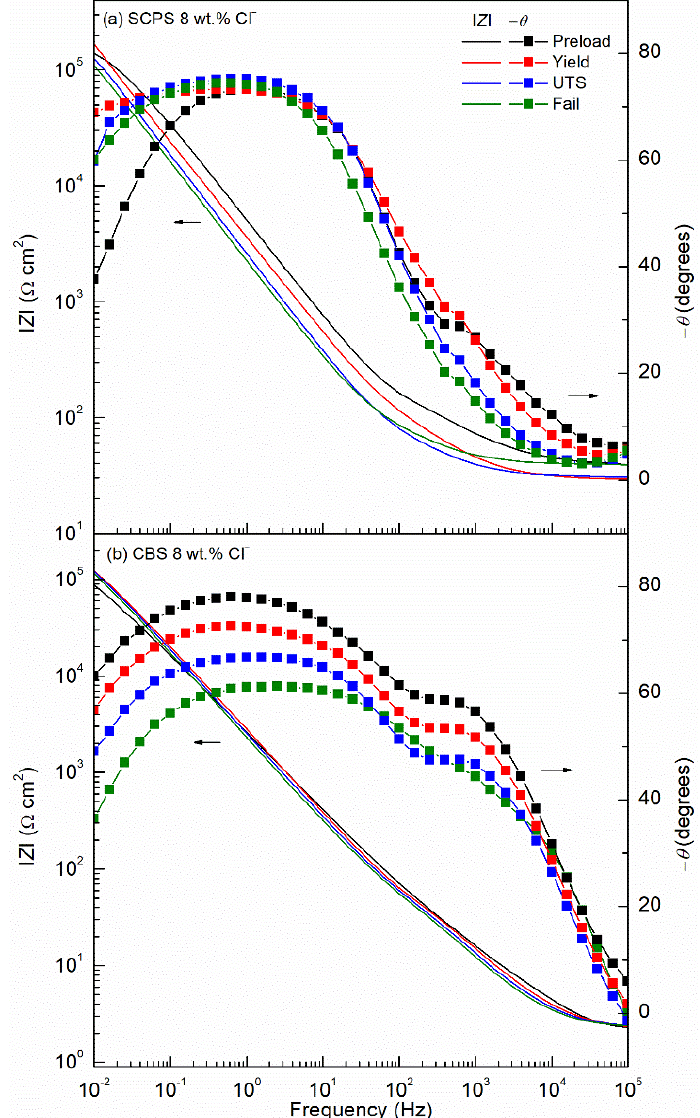
Figure 9. Bode plots of UNS S32205 reinforcement during SSRT: ( a ) simulated concrete pore solution (SCPS, pH 12.6), and ( b ) carbonated solution (CBS, pH 9.1).